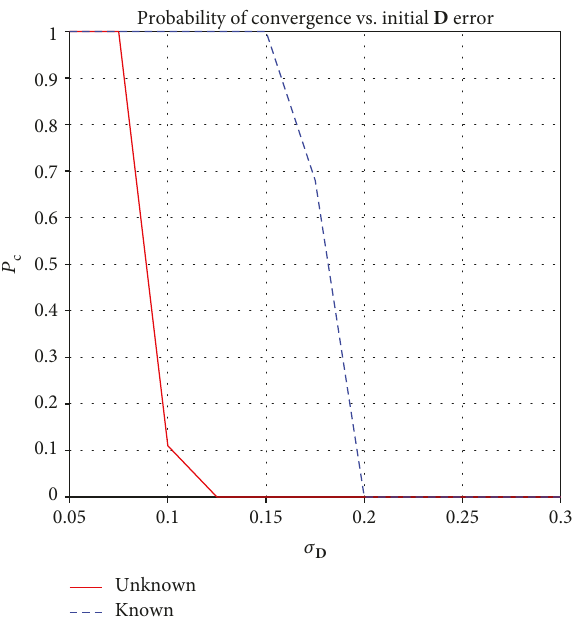
Figure 8: The probability of convergence as a function of the initial D mismatch 𝜎 , when all DOAs are unknown and when some are D known.